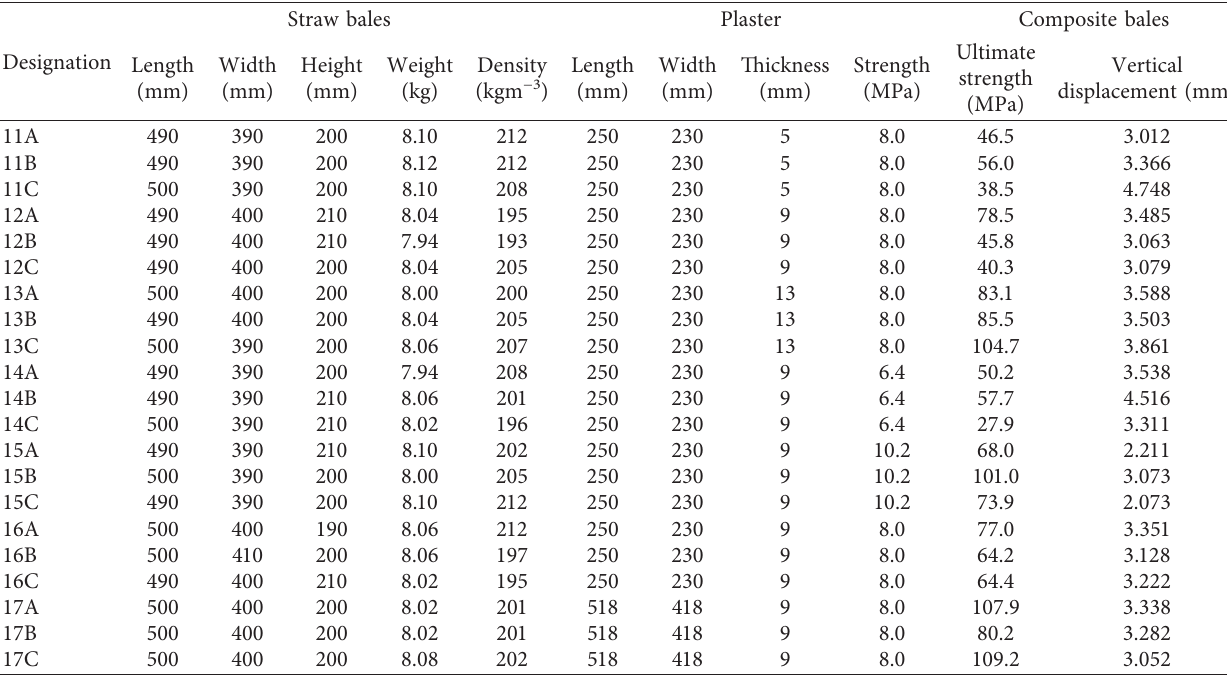
Table 2: The parameters of plastered straw bale specimens.